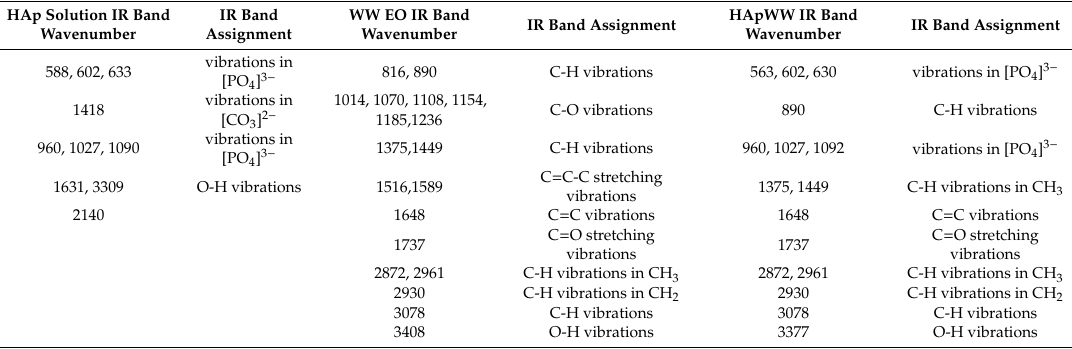
Table 3. Assignment of IR bands identified in the IR spectra of HAp, WW EO and HApWW. HAp Solution IR Band IR Band Wavenumber